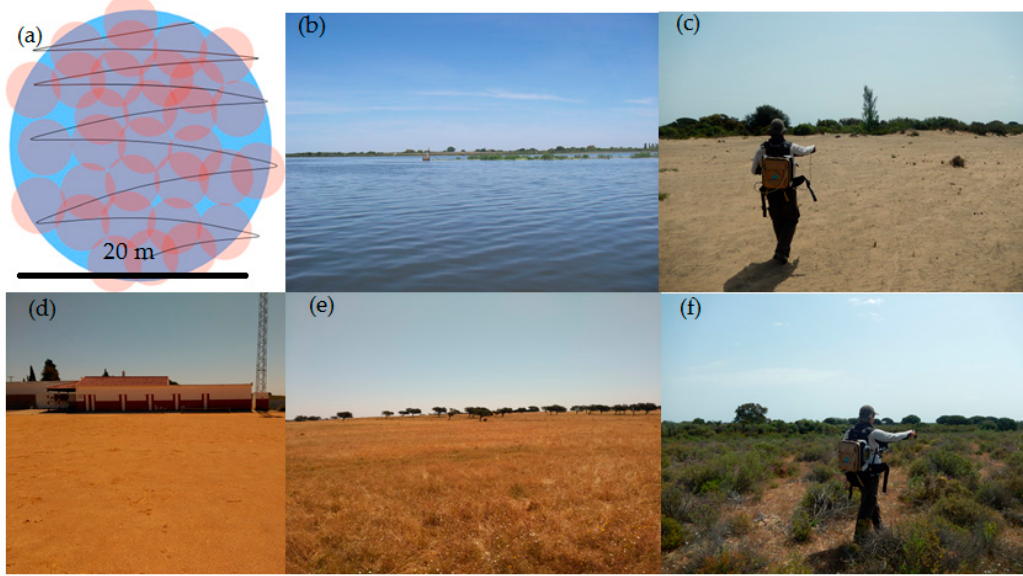
Figure 3. ( a ) Sampling footprint; ( b ) Shallow lake water (DG, 1 June 2017); ( c ) Sand dune (DG, 1